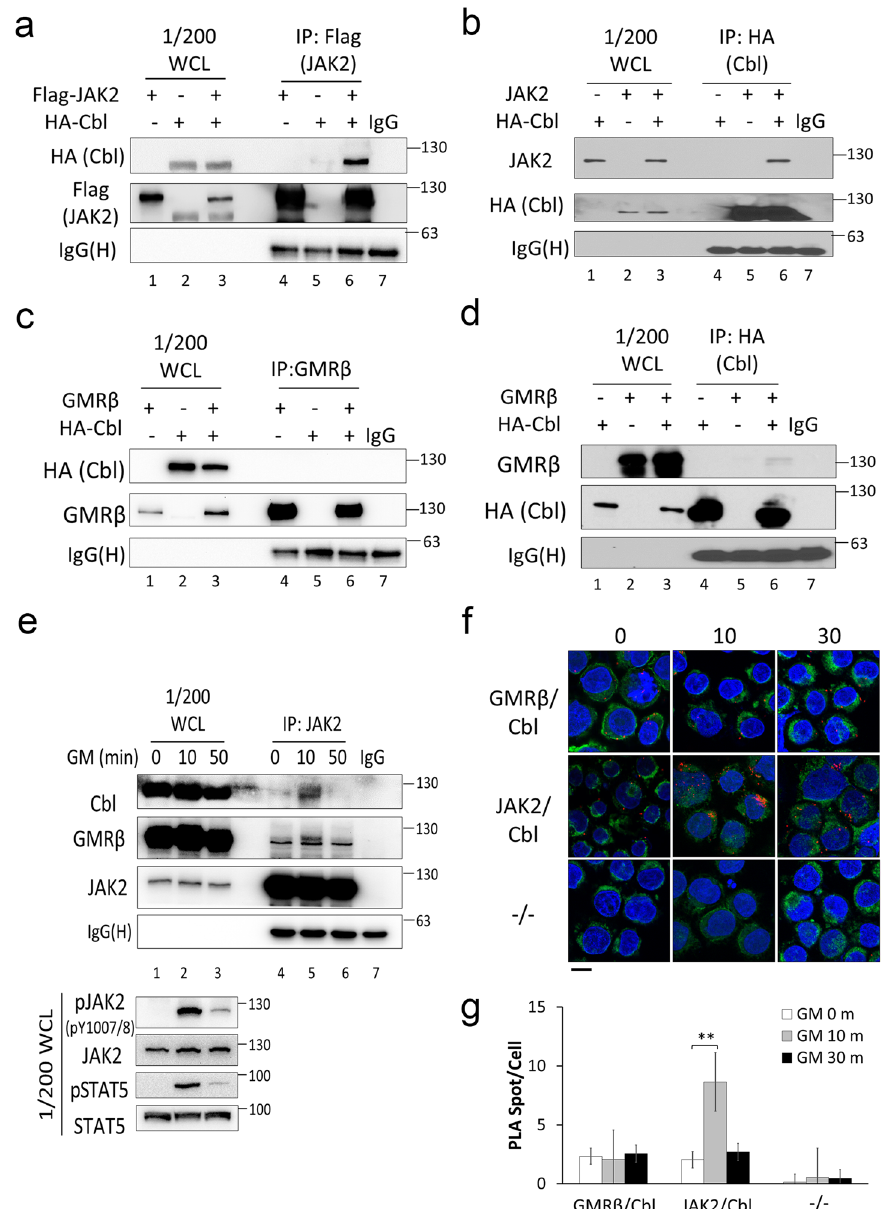
Figure 4. Cbl interacts with JAK2 during GM-CSF stimulation. ( a , b ) The interaction between JAK2 and Cbl. 293 T cells were co-transfected with combinations of plasmids encoding HA-tagged Cbl and Flag-tagged ( a ) or non-tagged JAK2 ( b ), and their WCL were IPed using an anti-Flag affinity gel ( a ) or an anti-HA affinity resin ( b ). The IPs, as well as their respective WCL (input control), were analysed by Western blot using the indicated antibodies. ( c , d ) Analysis of the interaction between GMR β and Cbl. 293 T cells were co-transfected with combinations of plasmids encoding HA-tagged Cbl and un-tagged GMR β , and WCL were IPed with ( c ) anti-GMR β -protein G beads or ( d ) an anti-HA affinity resin. Western blot analysis was performed as described above. ( e ) The interaction between endogenous JAK2 and Cbl is cytokine-dependent. After serum starvation overnight, TF1 cells were stimulated with or without GM-CSF (GM) (1 ng/mL) for 10 or 50 min, and WCL were IPed with an anti-JAK2 antibody. Cells were analysed as described above. ( f , g ) Cytokine-induced endogenous protein association was detected using Duolink ® in situ PLA. After serum starvation overnight, TF1 cells were treated with or without GM-CSF for 10 to 30 min. Cells were fixed onto glass slides and then co-stained with a rabbit anti-Cbl antibody and either mouse anti-GMR β (top row) or mouse anti-JAK2 antibodies (middle row), or no primary antibody control (bottom row). The PLA reaction products (PLA spots, red) were detected by confocal microscopy. Nuclei were stained with DAPI (blue), and the plasma membrane was stained using CellMask ™ plasma membrane stain (green). The scale bar represents 10 μ m. ( g ) Quantitation of data in ( f ) obtained from at least 500 cells per condition. Data are presented as mean ± SEM from two independent experiments. Statistical significance ( ** P < 0.01) was determined by t-test. WCL: whole cell lysates. IgG(H): IgG heavy